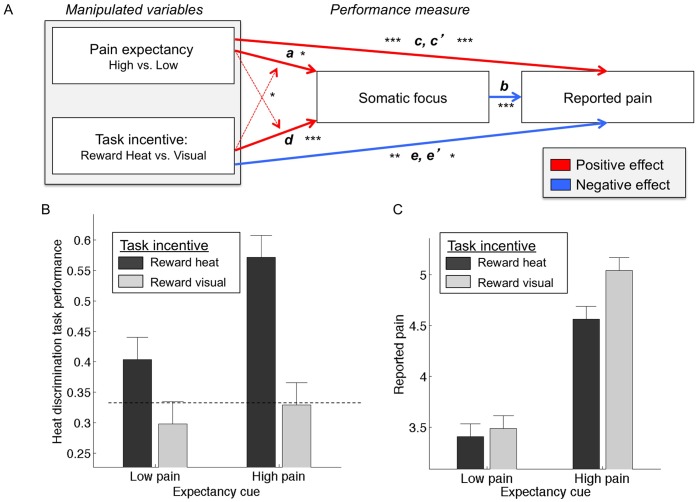
Expectancy and task incentive effects on pain and somatic focus.A. Mediation Model Results: There were main effects of: 1) Expectancy Cue (high vs. low) on Somatic Focus (Path a); 2) Somatic Focus on pain ratings (Path b); 3) Expectancy cue on pain ratings (Path c); 4) Task-Incentive Cue on Somatic Focus (Path d); and 5) Task-Incentive cue on pain ratings (Path e) (see below for details of main effects; full statistics are presented in Table 1). Expectancy effects on pain reports were mediated by changes in somatic focus (c – c’) with a negative mediation effect, indicating that increases in somatic focus partially suppressed the pain-intensifying effects of high pain expectancy (p<0.05). The effect of Task-Incentive cue on pain was mediated by changes in somatic focus (e – e’) (p<0.05). These results indicate that incentivizing the heat discrimination task reduced pain by increasing somatic focus. B. Heat discrimination performance as a function of Task-Incentive Cue and Expectancy Cue. Main effect of Task-Incentive Cue on Somatic Focus (corresponding to Path d): Participants performed at chance (dashed line) when visual task was incentivized, and above chance when heat-discrimination task was incentivized (p<0.001). Main effect of Expectancy Cue (high vs. low) on Somatic Focus (Path a): participants performed better on the heat discrimination task when they expected High pain (p<0.05). There was a significant interaction (dashed arrows in Figure 2A) between Task-Incentive Cue and Expectancy Cue, such that heat discrimination task performance was better under High pain expectancy (p<0.001), while effects under Low pain expectancy were marginally significant (p = 0.03 one-tailed). C. Pain ratings as a function of Task-Incentive Cue and Expectancy Cue. There was a main effect of Expectancy Cue (corresponding to Path c), such that participants reported less pain when medium heat was preceded by low-pain cues, relative to high-pain cues (p<0.001). There was also a main effect of Task Incentive Cue (Path e), such that participants reported less pain during moderate-pain trials when they were preferentially rewarded for performance on the heat discrimination task, relative to the visual discrimination task (p<0.01). There was also a main effect of Somatic Focus (Path b), such that somatic focus reduced pain (p<0.001).